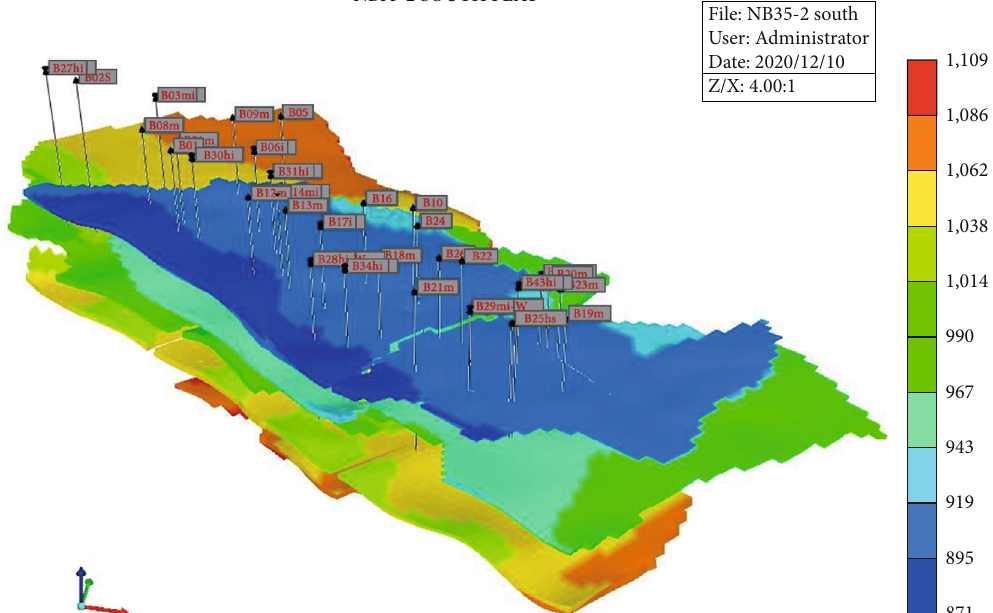
Figure 3: Numerical simulation model.